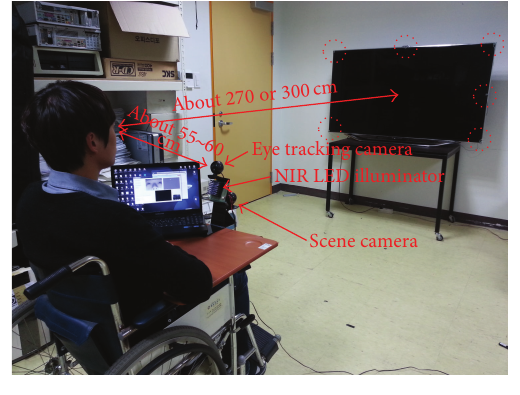
Figure 1: Proposed system.